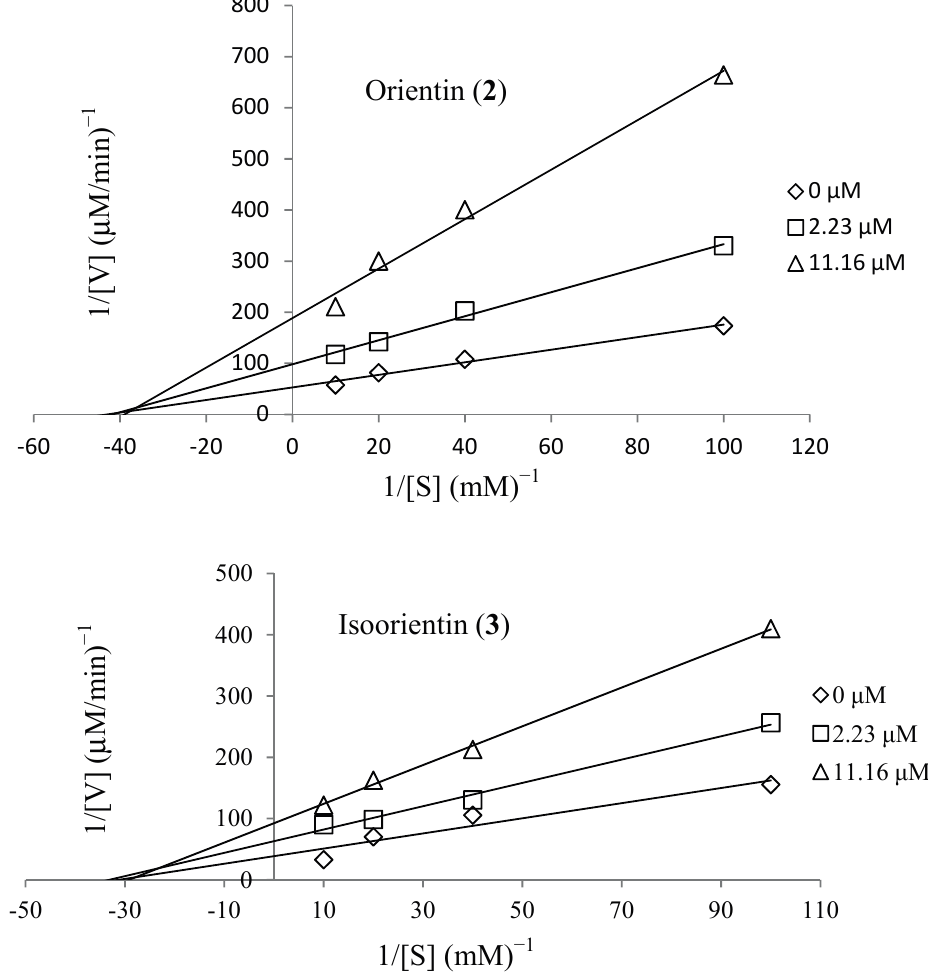
Figure 2. Lineveaver-Burk plots showing the reciprocal of the velocity (1/v) of recombinant rat lens aldose reductase versus the reciprocal of the substrate concentration (1/s) with DL -glyceraldehyde as the substrate at concentrations of 0.1 to 1